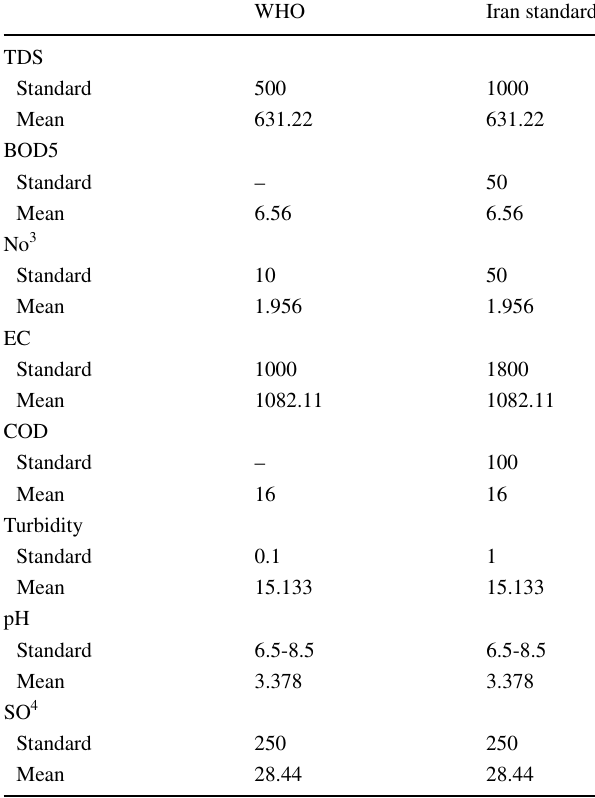
Table 5 Comparison of physicochemical values with national and international standards in the fall and winter seasons (high-water sea- son) WHO